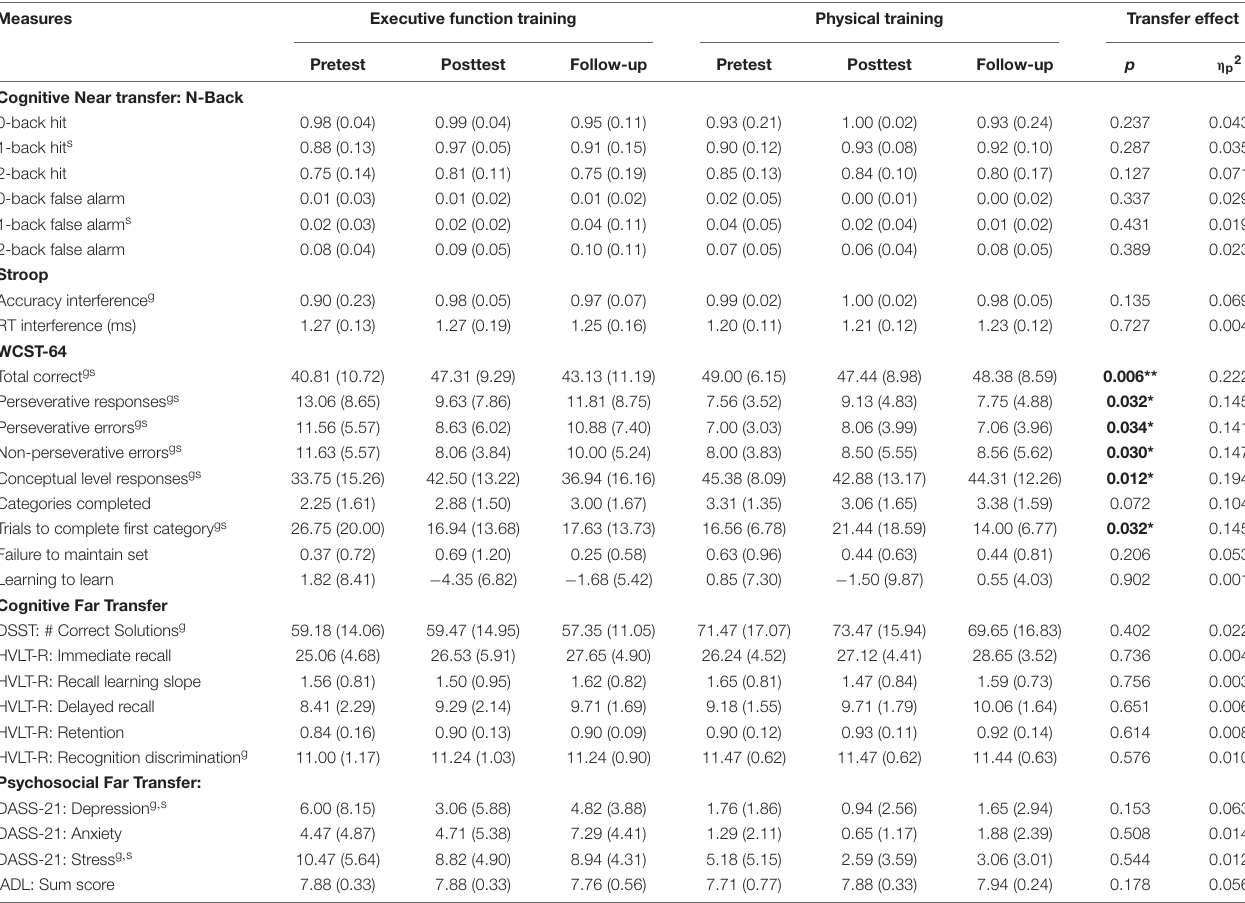
TABLE 2 | Performance at pretest, posttest, and follow-up sessions, as well as the transfer effects of the follow-up sample ( N =